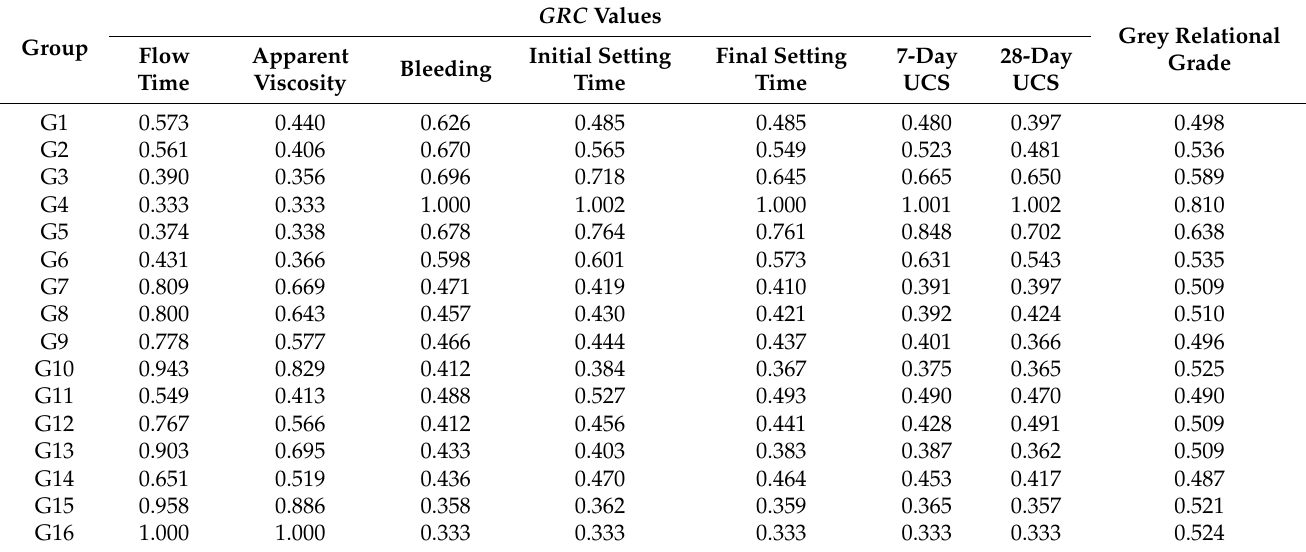
Table 10. GRC values of different properties of the UC-based slurry.